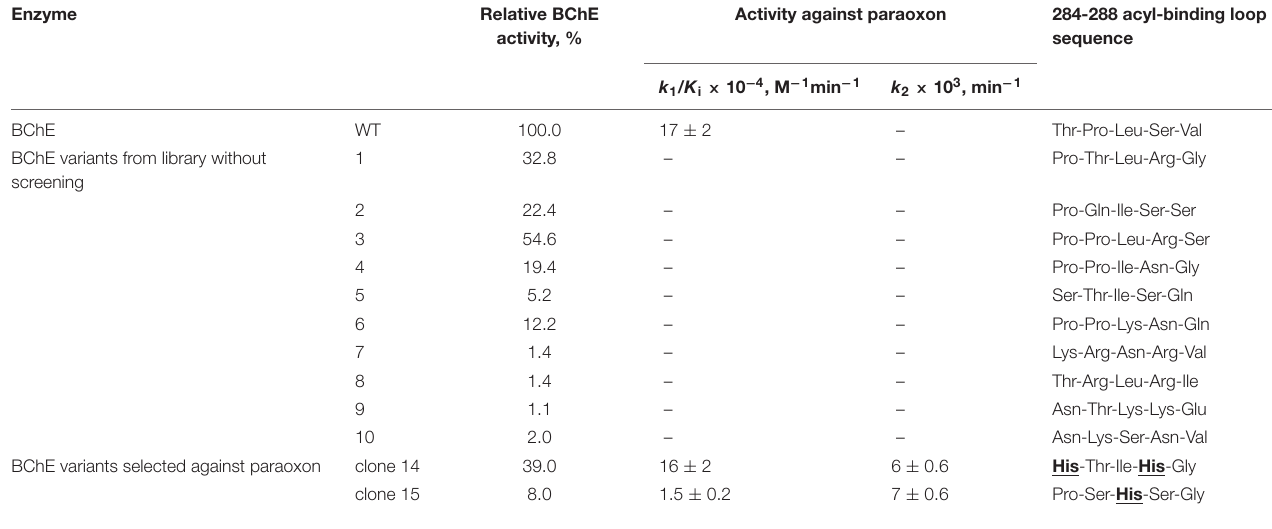
TABLE 1 | Kinetic and structural analysis of specific esterase and paraoxonase activity of selected BChE variants. Enzyme Relative BChE